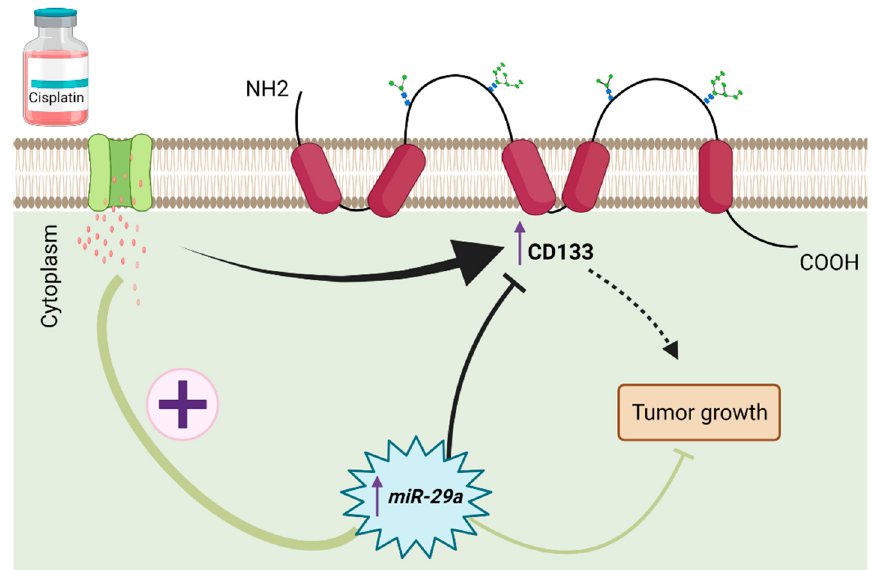
Figure 3. Treatment strategies for CD133+ cisplatin-resistant glioblastoma cells. CD133 as pentaspan transmembrane glycoprotein localized in protrusions of normal and cancer cells. Positive (CD133+) cells are regarded as tumor initiation cells in GBM. High CD133 expression confers resistance to glioma therapy and causes tumor growth. MiR-29a as a specific miRNA directly regulates CD133 expression. In fact, miR-29a promotes cisplatin-induced apoptosis via suppressing CD133 expression. Furthermore, using combination therapy including overexpression of miR-29a and cisplatin treatment substantially suppressed tumor growth in GBM than cisplatin treatment